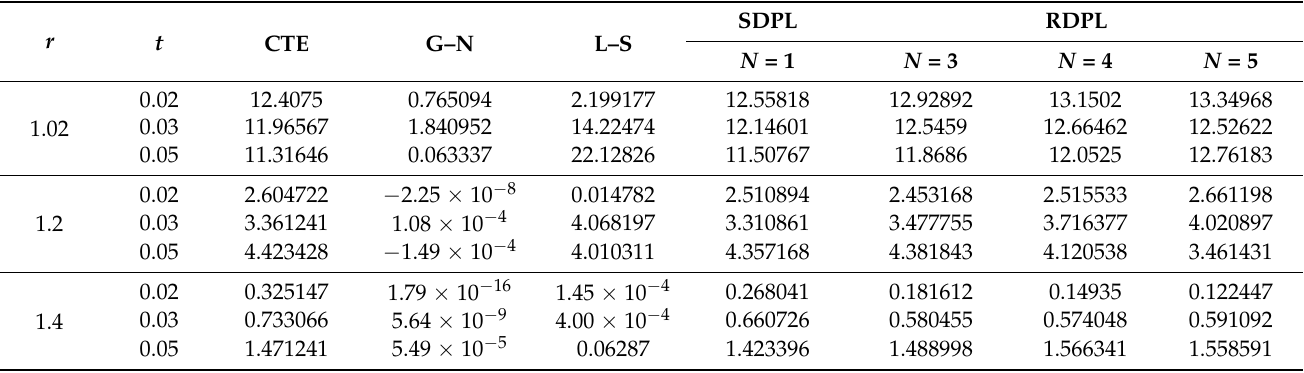
Table 3. Effects of dimensionless time t on temperature Θ according to different thermoelasticity theories with several values of r